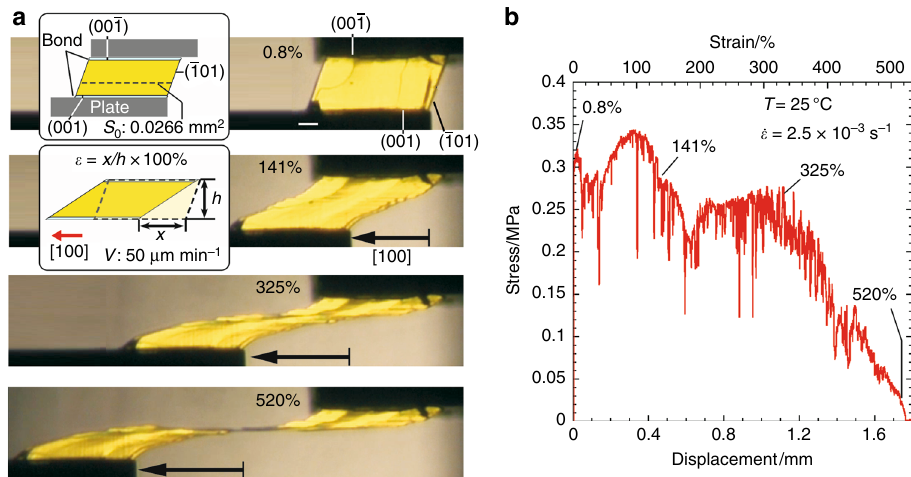
Fig. 2 Shear test of a crystal of 1 : superplasticity. a Snapshots during crystal deformation. Scale bar, 100 μ m. b Stress – strain curve of a . The crystal deformation was observed under a polarizing microscope and measured under the strain rate _ ε of 2.5 × 10 − 3 s − 1 (0.833 μ m s − 1 / 338 μ m) at room